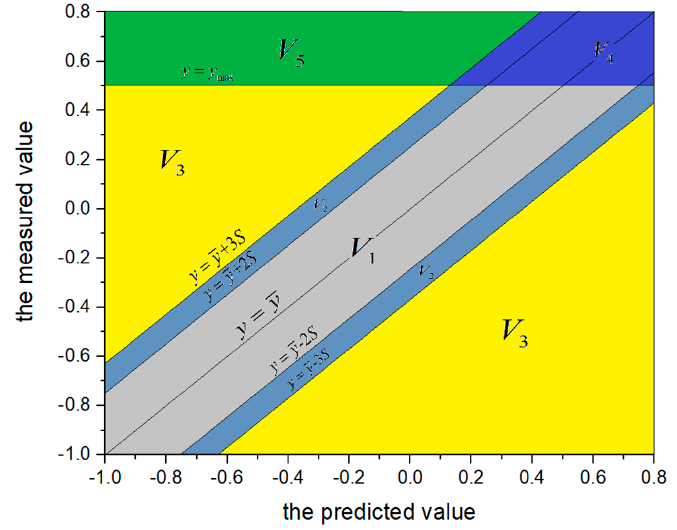
Figure 2. The diagram about risk assessment for the evaluation indexes. Table 1. The evaluation index for single monitoring point.